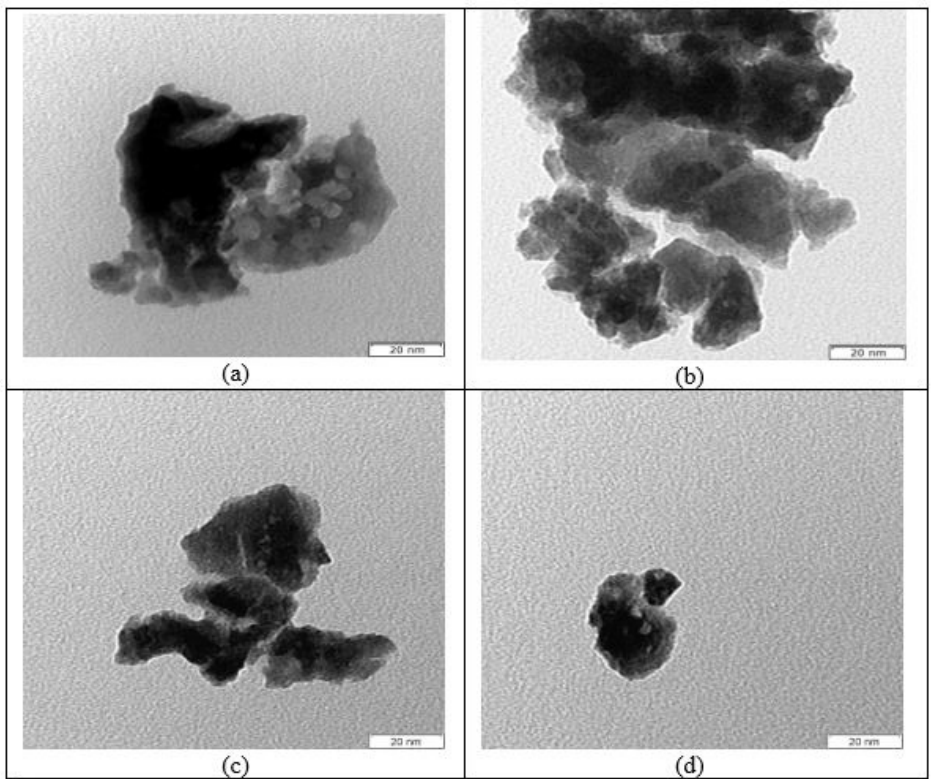
Figure. 5. Electron Transmission Microscopy micrographs of powder precursor before (a, b) and after (c, d) milling with Zirconium